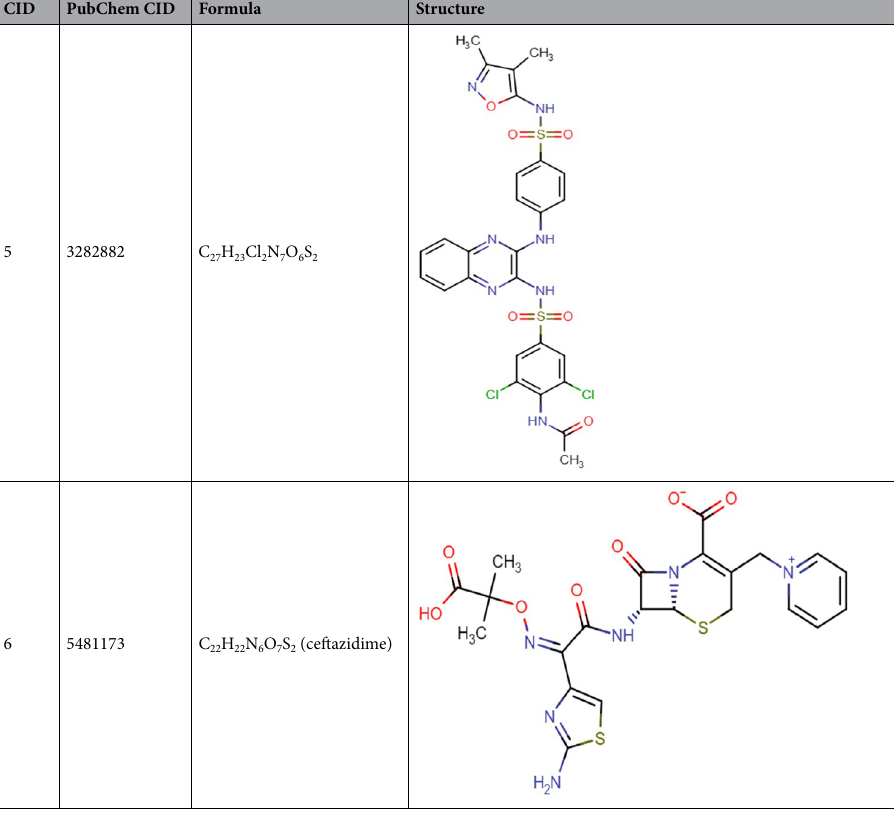
showed binding affinities of − 8.5 (kcal/mol) with various numbers of hydrogen bonds and other interactions. Compound CID:3 formed six hydrogen bonds with the active site residues TYR449, GLN493, and GLY496. In addition, four hydrophobic interactions of the types T-shaped pi-pi, amide pi-stacked, alkyl interactions with TYR449, TYR505, LEU452, and GLN493, and two halogen bonds with GLN493 and LEU492. Compound CID:4 formed five hydrogen bonds with the RBD binding site residues GLN493, SER494, and GLY496 and six hydrophobic interactions of the types—pi–pi stacked, pi—alkyl, and alkyl with key residues ARG403, TYR449, PHE497, TYR505, and TYR495. Compound CID:5 formed seven hydrogen bonds with residues ARG403, TYR453, GLY496, and GLN498 and seven hydrophobic interactions of the types T-shaped pi–pi, pi—alkyl, and alkyl with residues TYR449, TYR505, LYS417, and LEU455. In addition, one pi – cation electrostatic interaction was formed with ARG403. Ceftazidime was considered a control, giving a binding affinition of − 6.2 (kcal/mol), and formed six conventional hydrogen bonds with residues ARG403, TYR453, GLY496, TYR449, and GLN498. In addition, attractive electrostatic forces, one pi – alkyl interaction with residues ARG403 and TYR449, and hydrophobic interactions were involved in the ceftazidime-RBD interaction. In addition to the mentioned con- tacts, the six compounds interacted with the interface residues by van Der Waals forces (Figs. 2 and 3). In addition to the reference compounds, the five compounds formed many bonds with key residues LYS417, TYR453, TYR505, ASN501 GLN493, GLY496, TYR449, GLN498, and LEU455 of the SARS-CoV-2 RBD, which may interrupt the viral host cell recognition process. The 5 phytochemical compounds investigated through molecular docking simulations here revealed significantly better binding energy. In contrast to the reference compounds, these five compounds established networks of hydrophobic interactions that contribute to the bind- ing affinity of the predicted complexes. MD simulations and binding free energy calculations. We further used GROMACS 2020.3 to run MD simulations on the five RBD-ligand complexes as well as the control compound on a 200 ns time scale to investigate the dynamic binding interactions and calculate the binding free energies. RMSD and RMSF. The root mean square deviation (RMSD) is a critical measure for analyzing the equilibra- tion of MD trajectories and determining the stability of protein–ligand complex systems during the simula- tion process. This value was calculated for each compound and compared to that of ceftazidime with respect to the initial pose as a reference frame. All compounds retained their docking position with some deviation (Fig. 4). Ceftazidime showed insignificant deviation (~ 0.18–0.27 nm) and high stability with rare major vari-